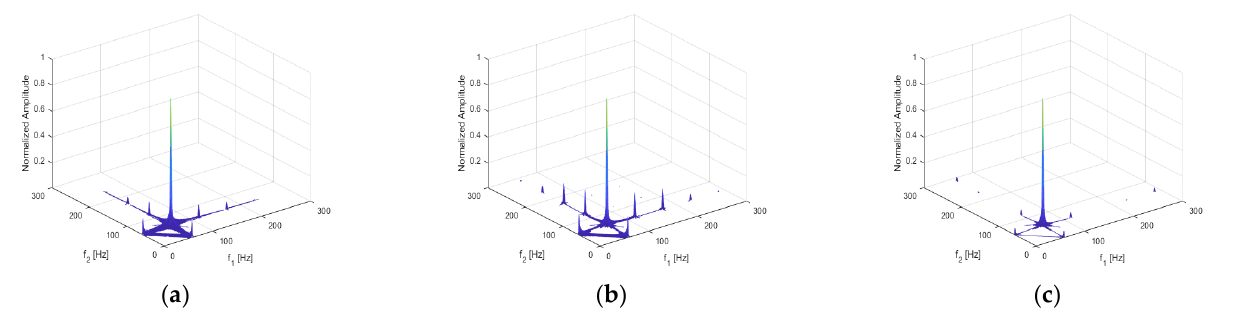
Figure 5. Bispectrum of ( a ) displacement response; ( b ) velocity response; ( c ) stress response.